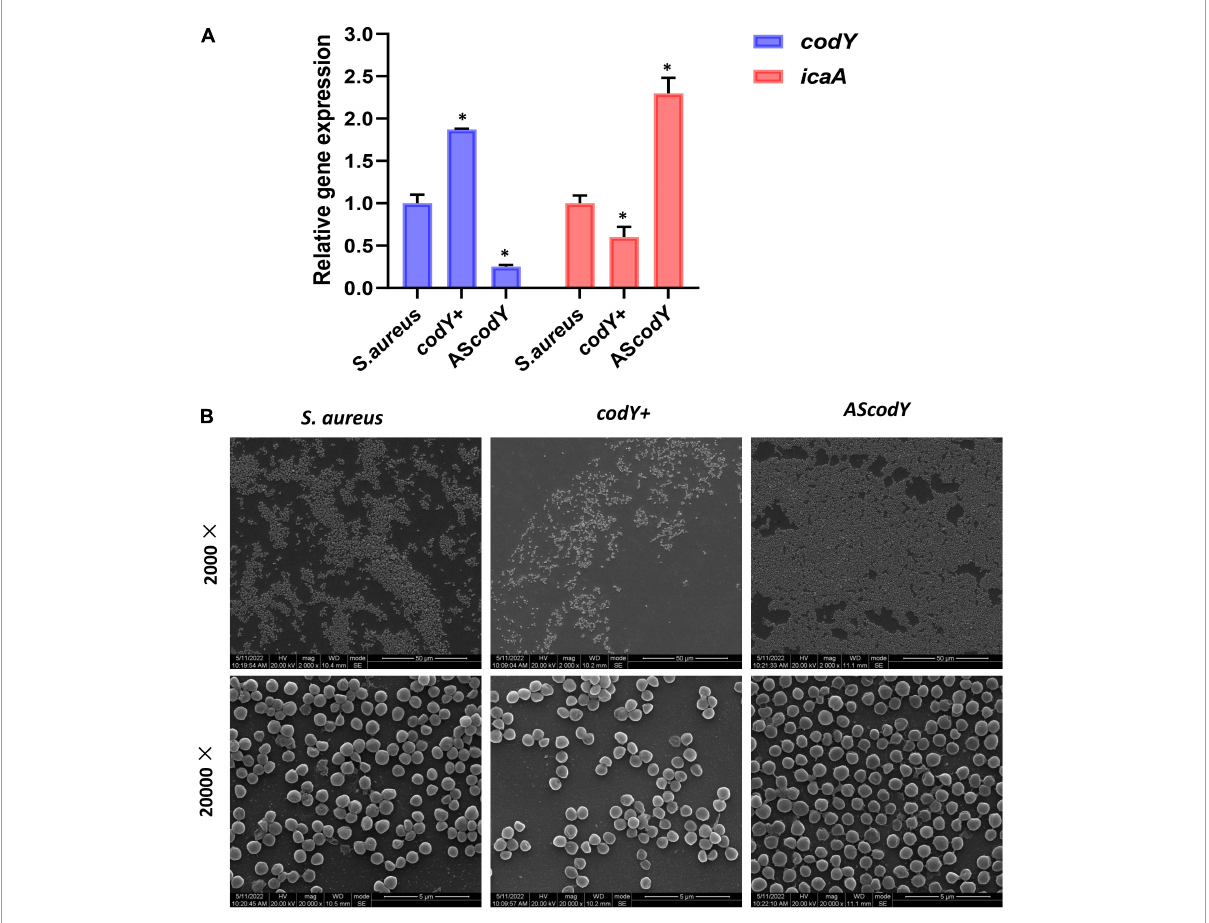
FIGURE4 CodY suppressed biofilm morphology and biofilm-associated genes. (A) Quantitative RT-PCR analysis showed the gene expressions in S. aureus , codY + and codY - mutant stains. S. aureus gene expression was relatively quantified by RT-PCR using 16S as an internal control ( n = 5, ∗ P < 0.05). (B) SEM images of S. aureus , codY + and codY - mutant